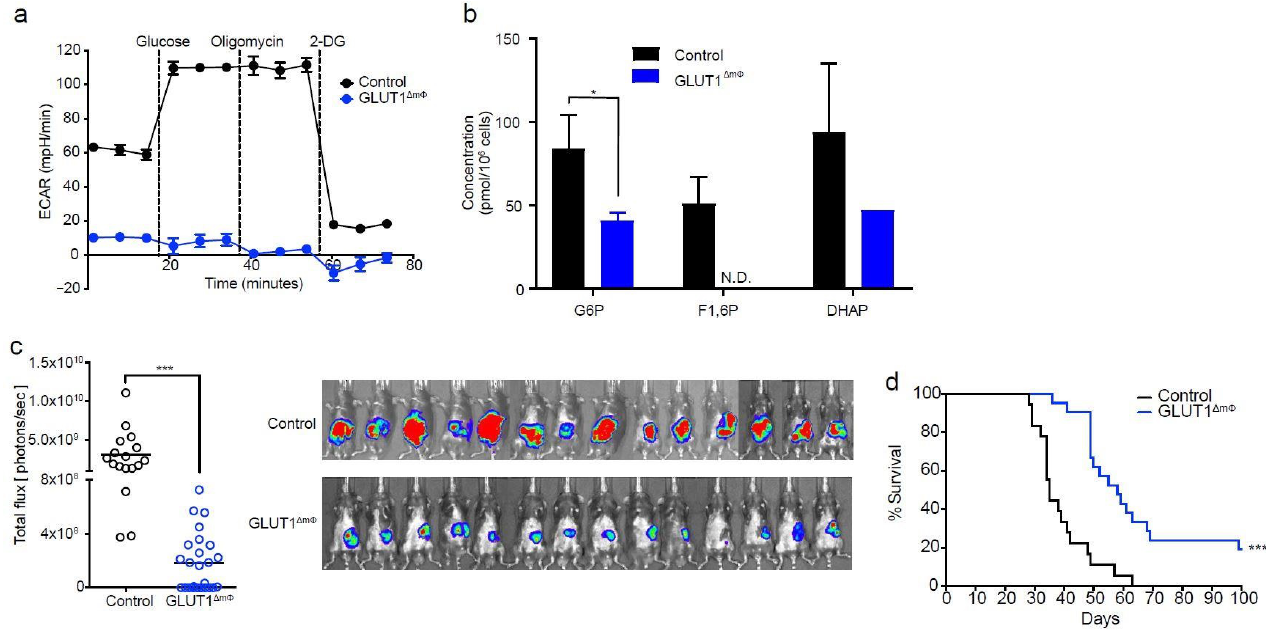
Figure 2. Macrophage-specific deletion of GLUT1 confers resistance to tumor growth. ( a ) Sorted PEC macrophages from control (LysM-cre and/or GLUT1fl/fl alone) and GLUT1 ∆ m Φ mice were rested at 37 ◦ C for 1 h and assessed for their glycolytic capacity in a live metabolic flux assay. Shown is a representative Seahorse trace of control (black) compared with GLUT1 ∆ m Φ (blue) ( n = 3 mice pooled per group, three independent experiments). ( b ) Ratio of area under mass peak of each metabolite in the glycolysis pathway derived from metabolomics profiling of control (black) and GLUT1 ∆ m Φ (blue) PEC macrophages (control, n = 3; GLUT1 ∆ m Φ , n = 4, n = 3 mice pooled per sample). ( c ) Orthotopic tumors from control and GLUT1 ∆ m Φ mice were monitored in vivo over time using BLI. Shown is a representative scatter plot of the total flux on Day 28 as calculated from the BLI images (control, n = 17; GLUT1 ∆ m Φ , n = 25, pooled from four independent experiments). ( d ) Shown is a Kaplan–Meier survival analysis of GLUT1 ∆ m Φ mice ( n = 21) compared with controls ( n = 18), pooled from two independent experiments. (Data are means ± SEM, * p < 0.05; *** p < 0.001 by unpaired student’s t-test with 95% confidence